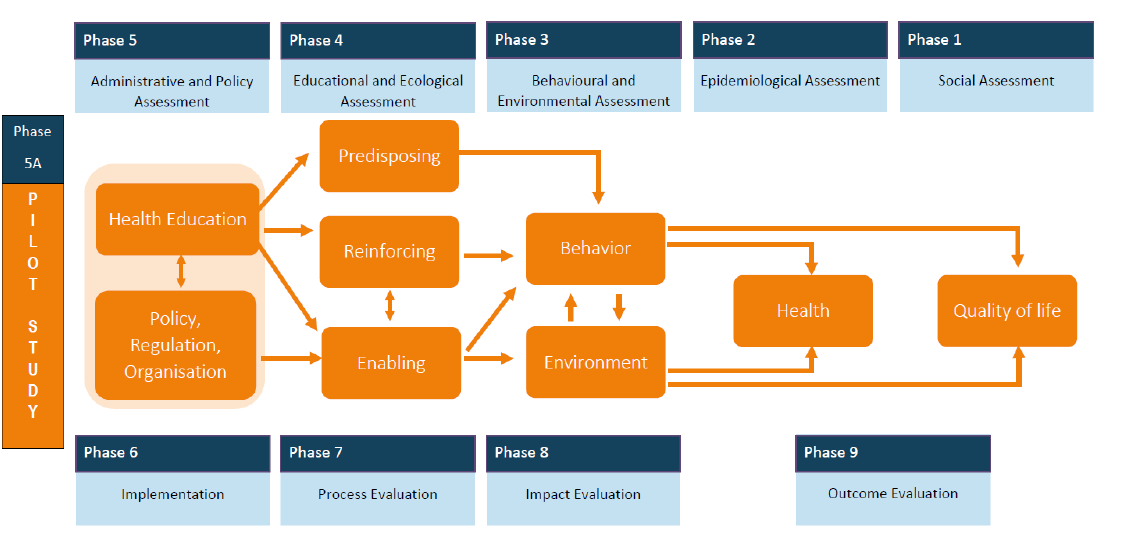
Figure 1. Generic representation of the PRECEDE-PROCEED Model Source: Green and Kreuter, 1999, p. 34 [11]. Table 1. Components of the PRECEDE-PROCEED model in the context of LISTEN UP.